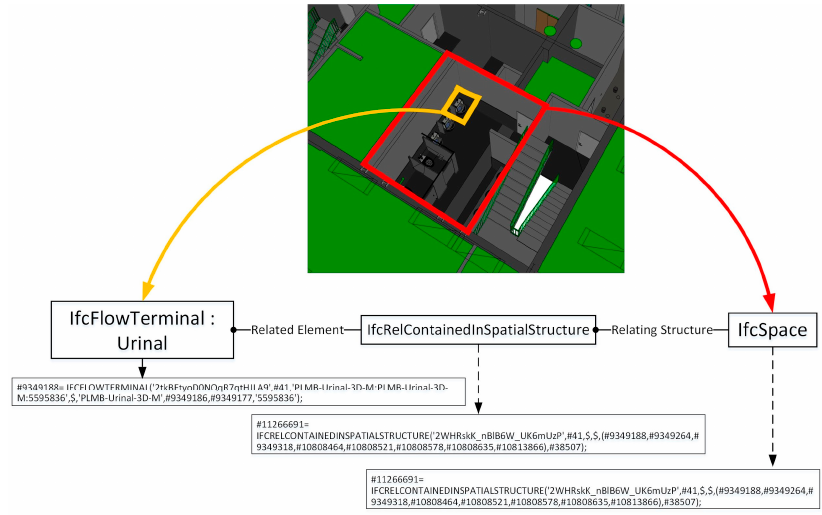
Buildings 2021 , 11 , 456 Figure 5. An example relationship between water closets and the washrooms they are located in.